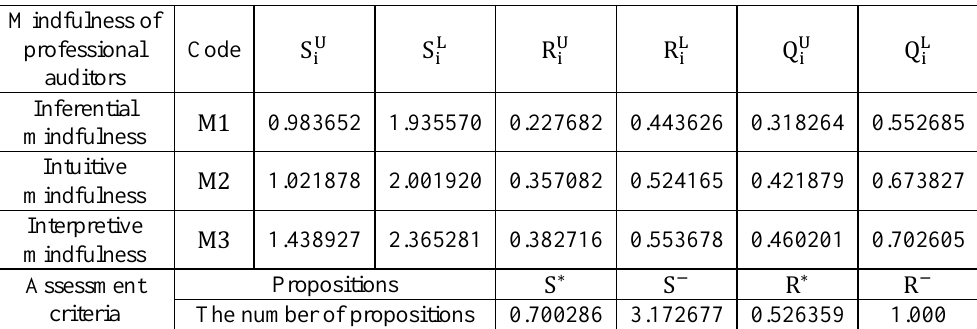
Table 12. Analysis of Grey Vikor Method